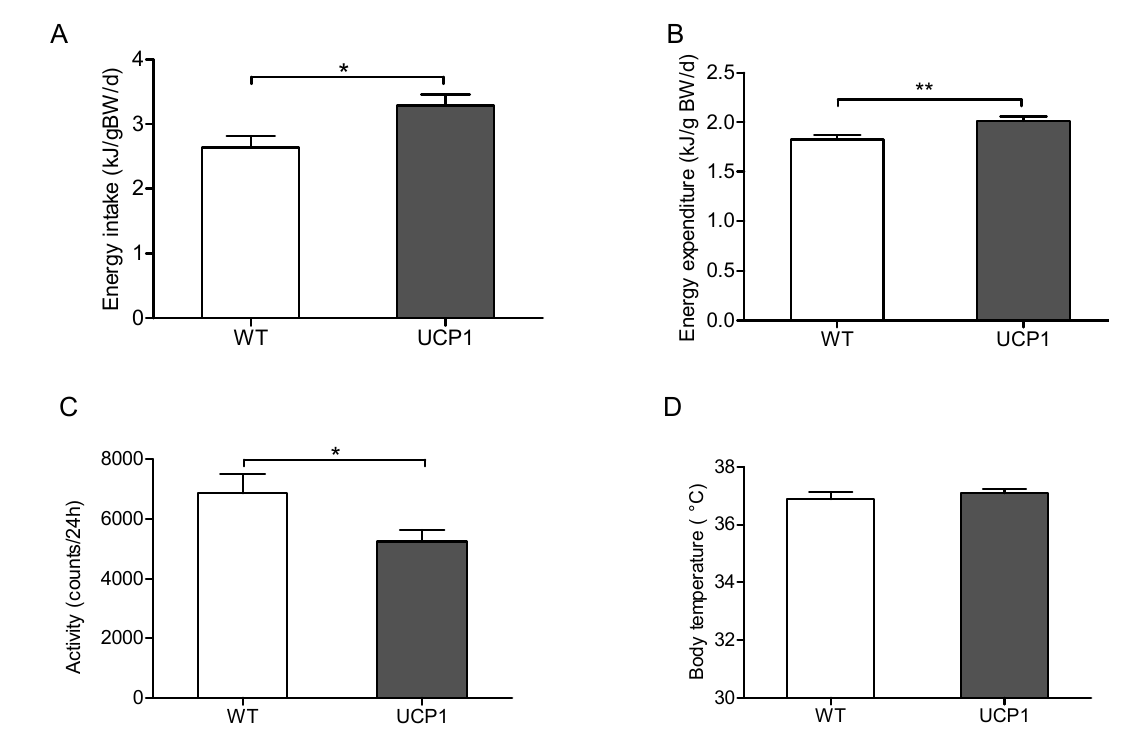
Figure 2. Energy intake ( A ), energy expenditure ( B ), activity counts over 24 h ( C ) and body temperature ( D ) in 12-week-old UCP1-TG (UCP1) and wild-type (WT) littermate controls fed a chow diet. Data are expressed as mean +/ − SEM ( n = 8); ( A – D ): Student’s t-test; * p < 0.05, ** p < 0.01.